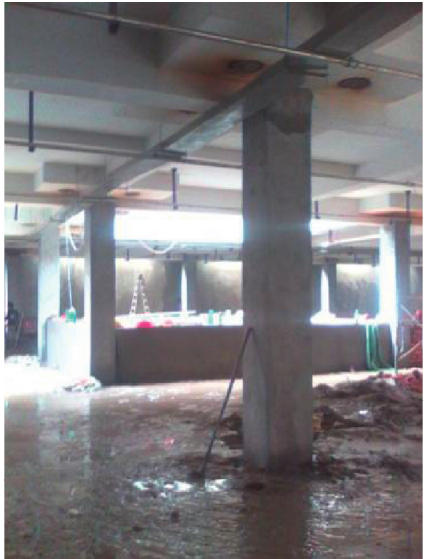
Figure 13: Main structure of the new